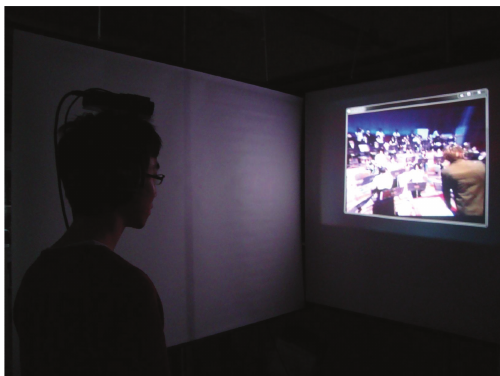
Figure 15: Participant using Concert Viewing Headphones